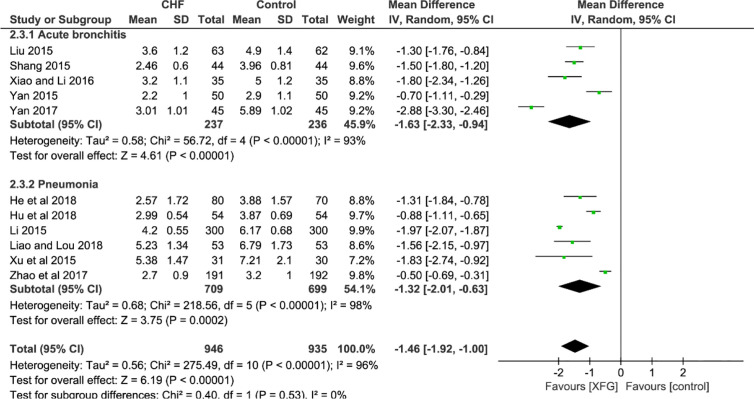
Forest plot and subgroup analysis of the RTF.